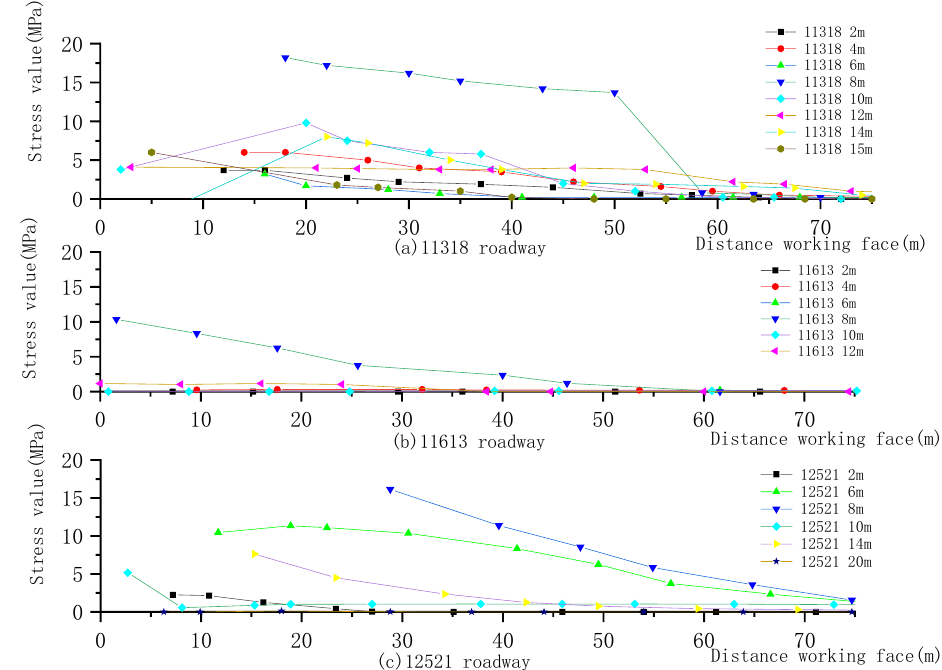
Figure 16. Comparison analysis diagram of vertical stress increment of low side within 75 m.